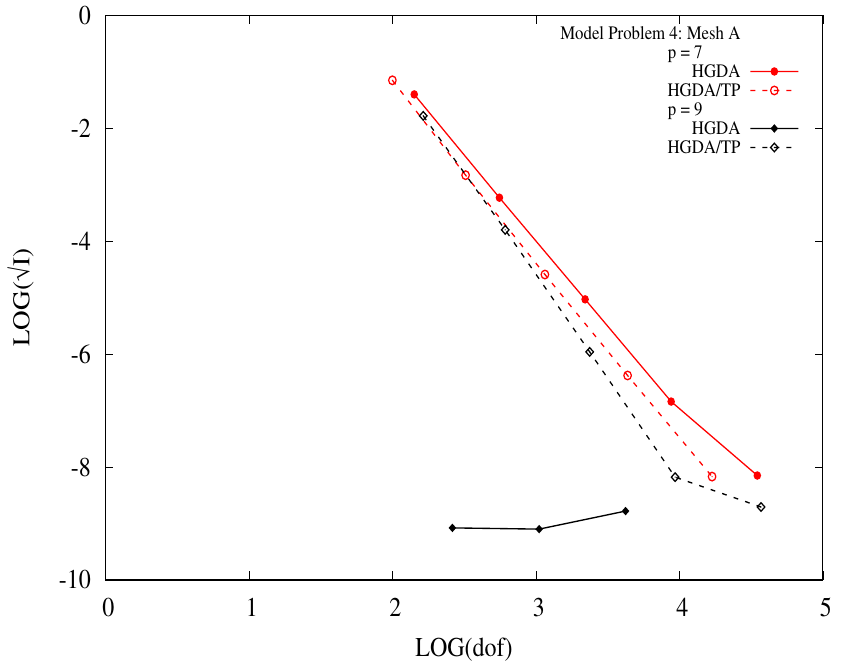
Figure 18. Residual function I versus dof, C 33 solutions: Model Problem 4 (Poisson’s Equation; Mesh A; HGDA/DG and HGDA/TP).